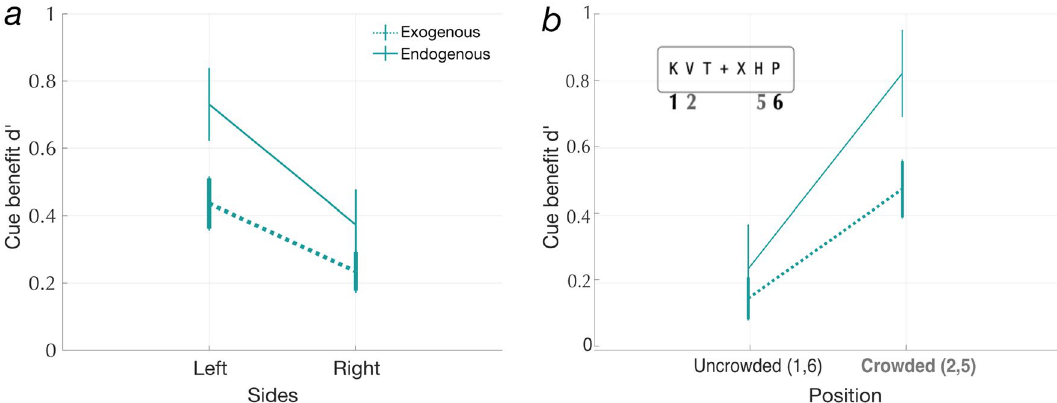
Figure 5. ( a ) cue benefits for the left and right hemifield. We see a significant main effect of cue type and hemifield but no significant interaction effect. ( b ) cue benefit for the most crowded and the least crowded letter positions. We see a significant main effect of letter crowding but no significant effect of cue type and no interaction between cue type and letter